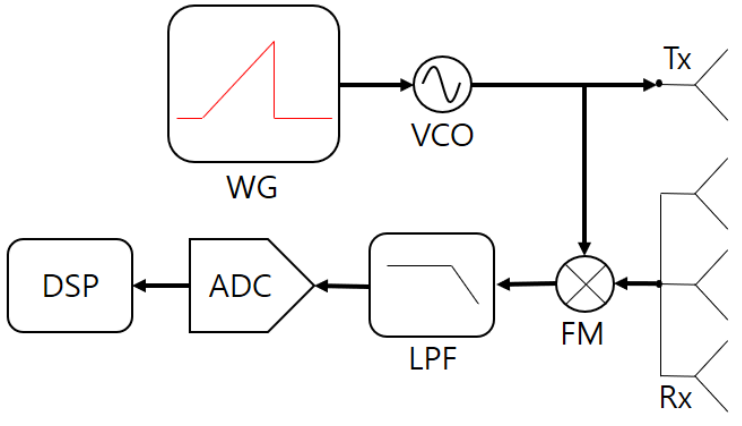
Figure 1. Configuration of the frequency-modulated continuous wave (FMCW) radar system.